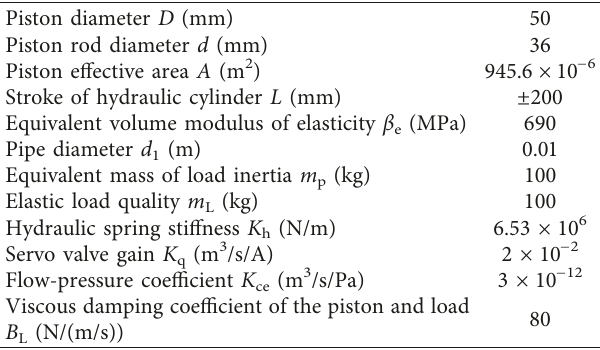
Table 1: Parameters based on the hydraulic system power